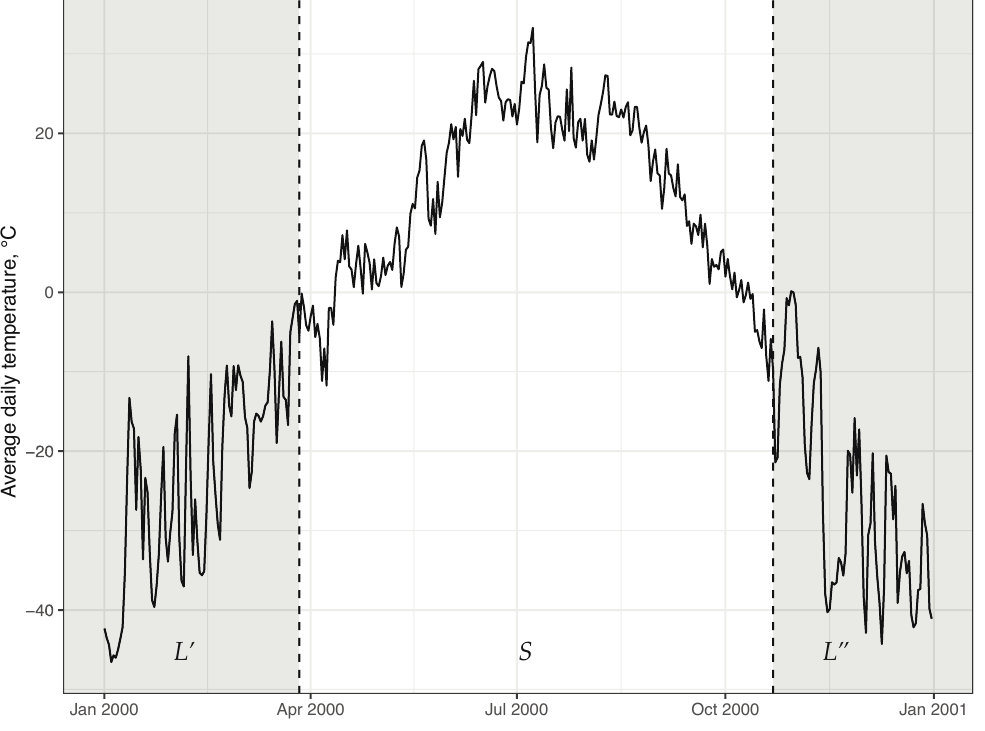
Figure 2. Diagram of the temperature and calculated logging season (shapes L (cid:48) and L (cid:48)(cid:48) ) and non-logging period (shape S ) for the sample Boguchany station (World Meteorological Organization (WMO) index = 29,282) in